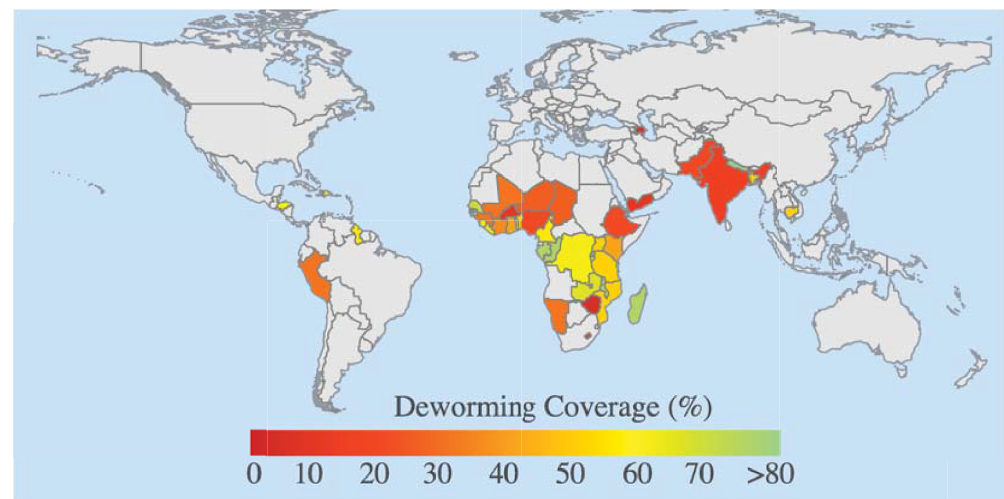
Fig 1. Study countries and deworming coverage over 2005–2016. We used data from the DHS for 45 STH endemic countries. For each, we computed the deworming coverage in pre-school age children. https://doi.org/10.1371/journal.pntd.0006500.g001 overall negative-exposure controls (Table A4, A5). We did not detect consistent associations between deworming and reduced risk of being underweight in the overall analysis, but did find a relationship in the sub-group of underweight children (0.02 standard deviation increase;